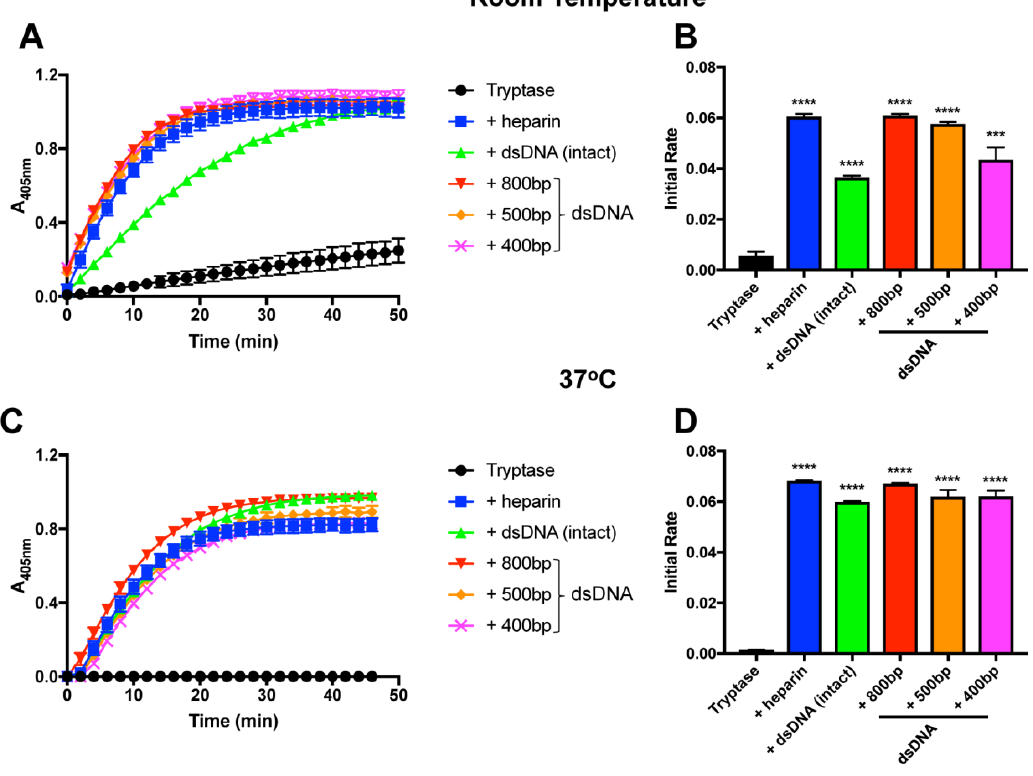
Figure 4. DNA or heparin do not rescue the activity of inactivated tryptase. ( A ) β -tryptase (0.07 μ g) was incubated at 37 °C for 3 h in the absence or presence of either heparin or dsDNA, followed by measurement of residual tryptase activity using S-2288. ( B ) Human β -tryptase (0.07 μ g) was enzymatically inactivated by incubation in the absence of heparin or dsDNA for 3 h (37 °C). After complete inactivation (3 h), tryptase was further incubated for 30 min, either alone or in the presence of either heparin or dsDNA as indicated. Tryptase activity was then measured using the chromogenic substrate S-2288. The data are representative of three independent experiments. Data are given as mean values ± SD ( n = 3).